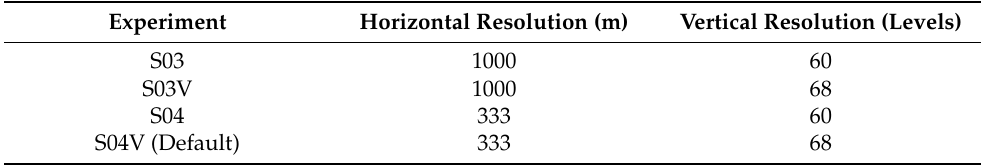
Table 2. Design of sensitivity